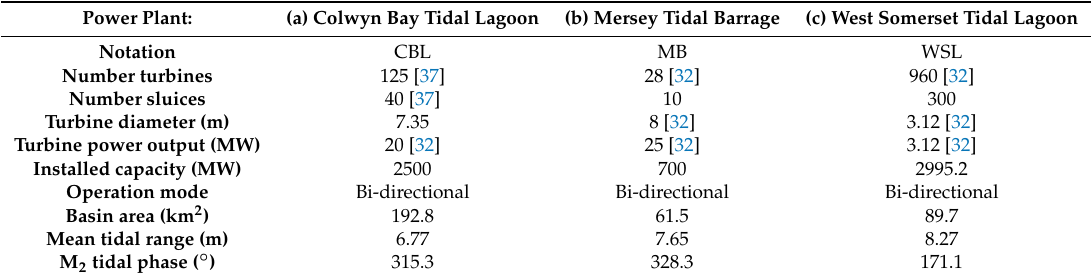
Table 1. Power plant specifications applied in this